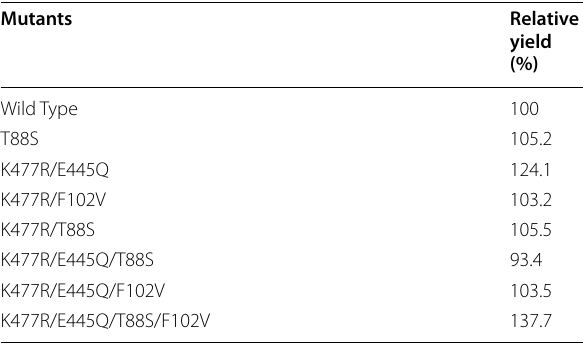
Table 1 Cadaverine yield of CadA multi-site mutants relative to the wild type Mutants Relative